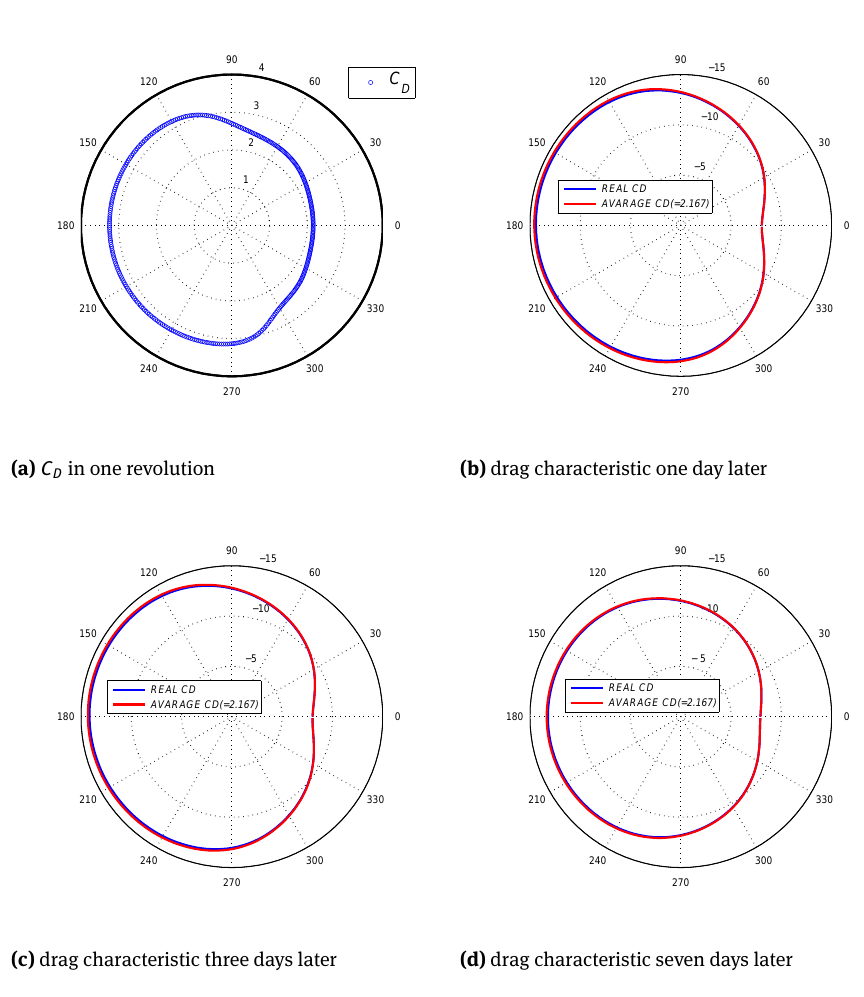
Figure 4. The drag characteristic of the flat plate in the orbit of CZ-3B 3rd stage